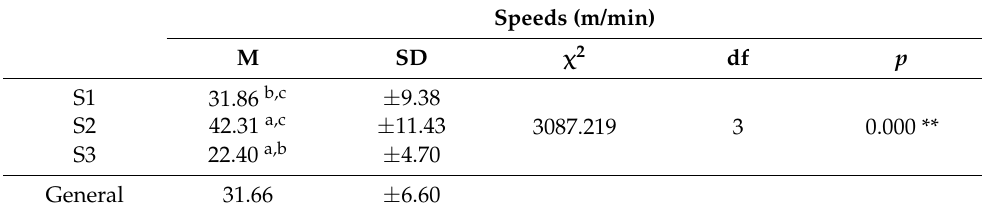
Figure 8. Frequency of hikers according to hours and sectors within the CR trail. Table 4. Descriptive data for the time and speed utilized for hiking the